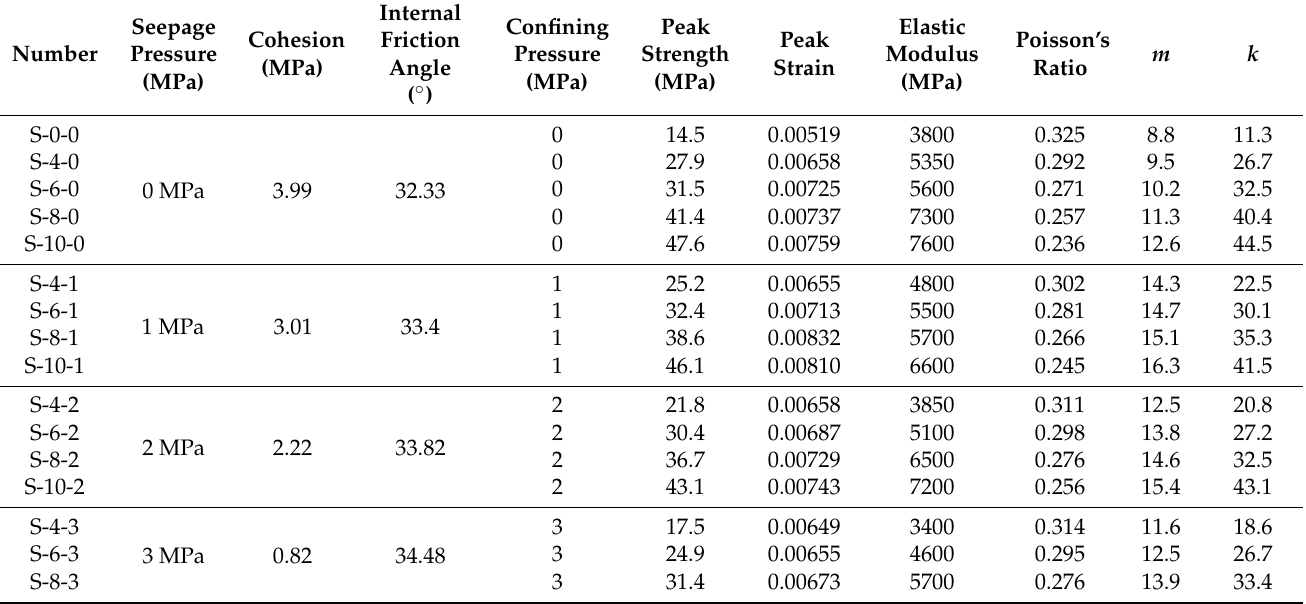
Table 1. Parameters of statistical damage